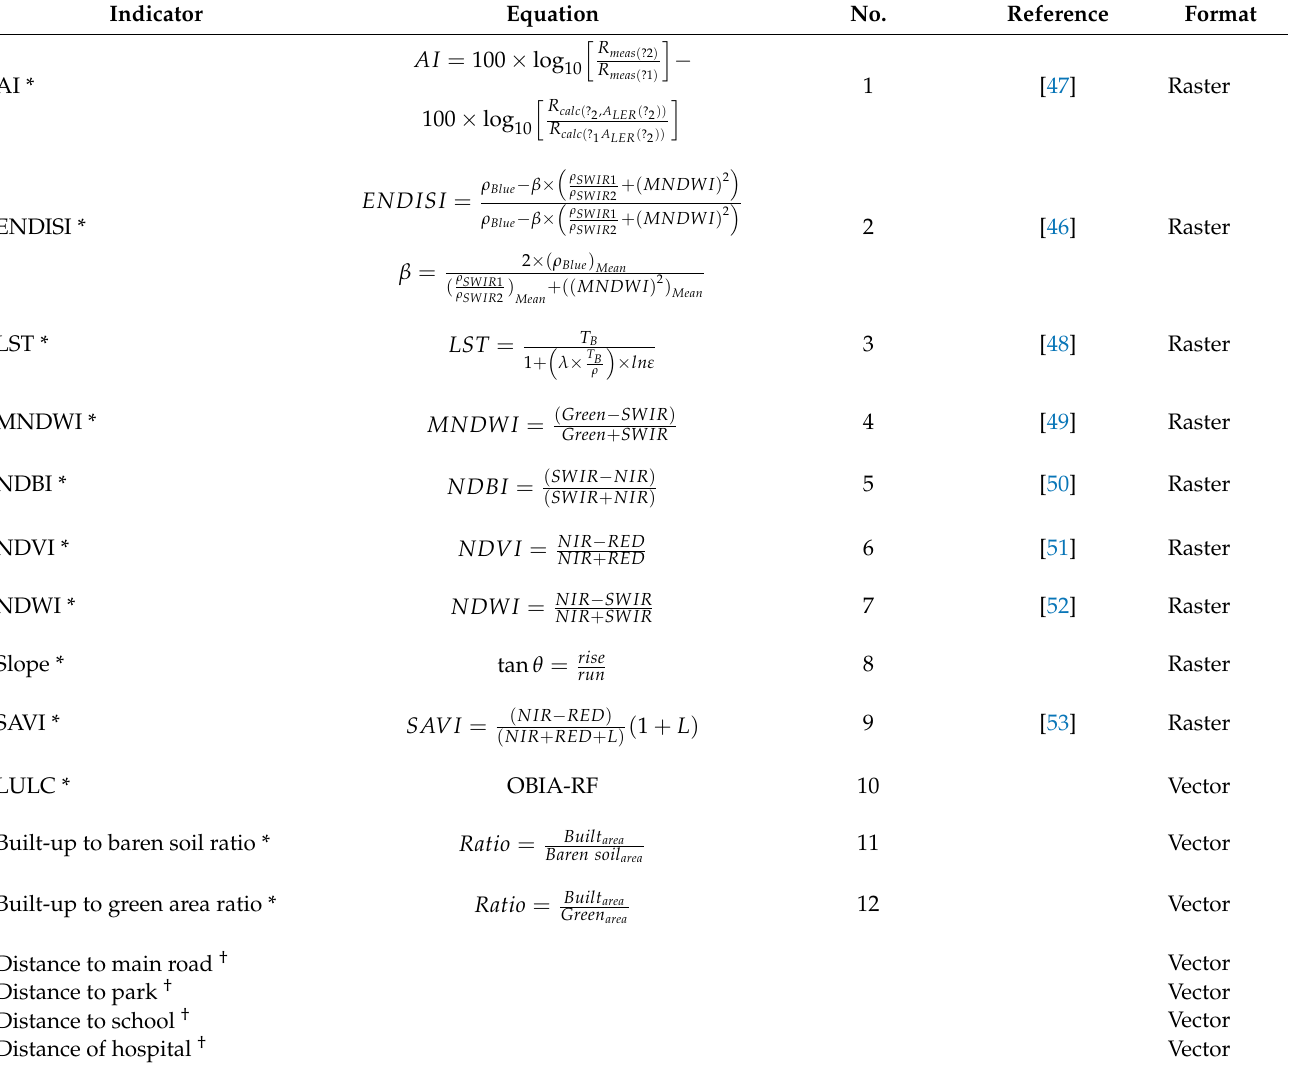
Table 1. Urban quality of life indicators extracted from remote sensing and GIS vector